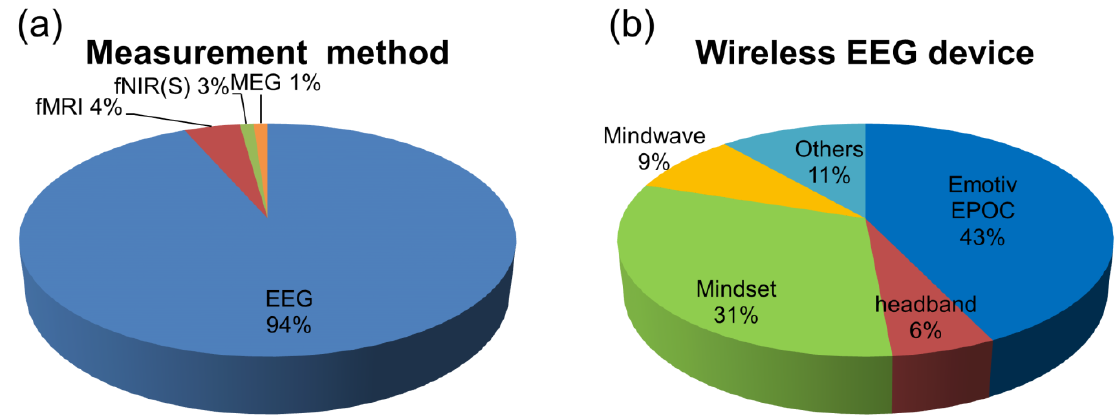
Figure 4. ( a ) Measurement methods (N = 92) and ( b ) wireless devices (N = 35) used in developing BCI games.